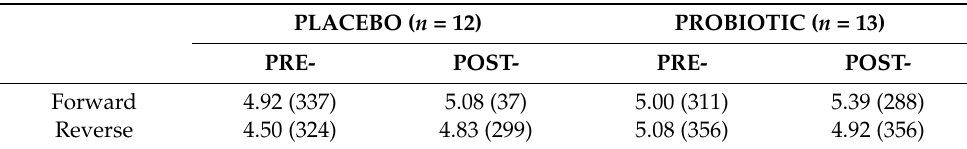
Table 3. Span of memory expressed by mean and standard error.